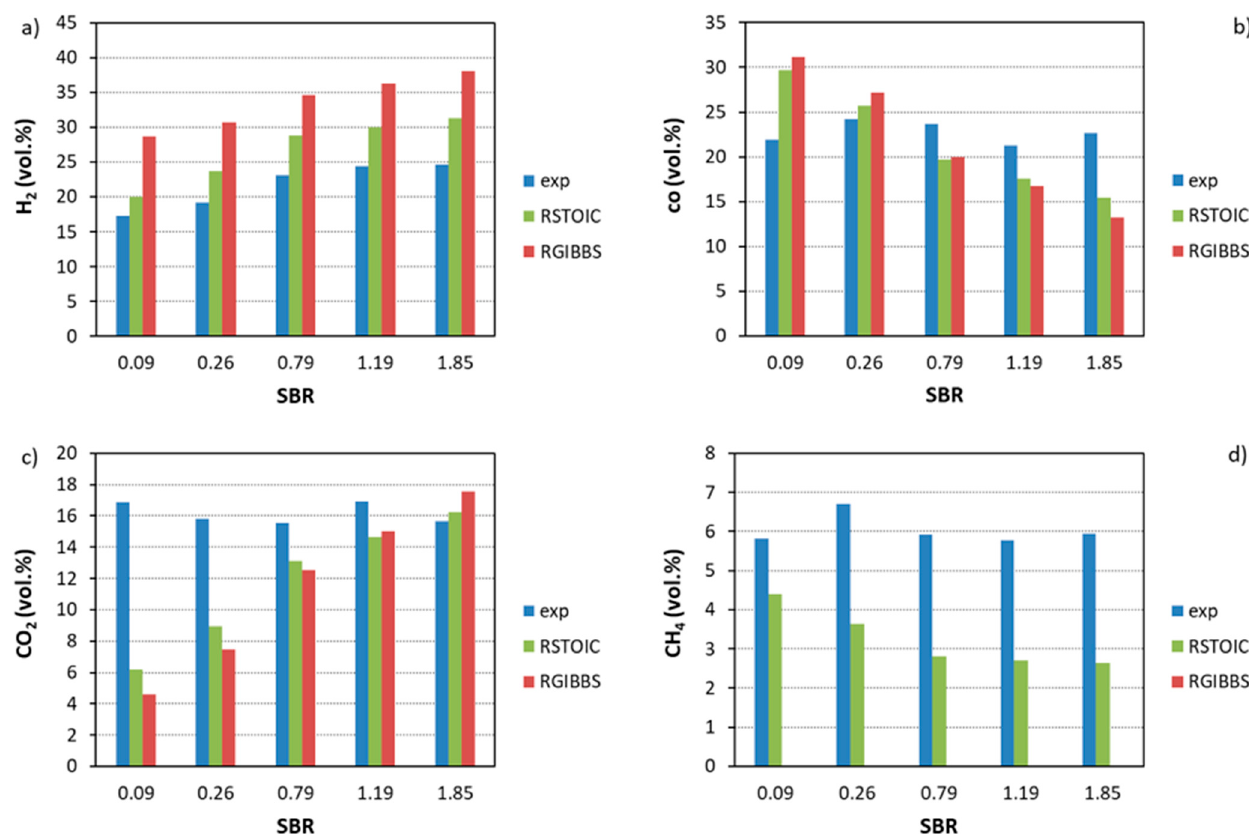
Figure 5. Comparison between the gas concentrations at different steam to biomass ratios during the gasification of PKS at 900 °C with stoichiometric ratio (SR) = 0.2, and the predictions obtained with stoichiometric and non-stoichiometric models: ( a ) H 2 , ( b ) CO, ( c ) CO 2 and ( d ) CH 4 (CH 4 values of RGIBBS model are negligible).